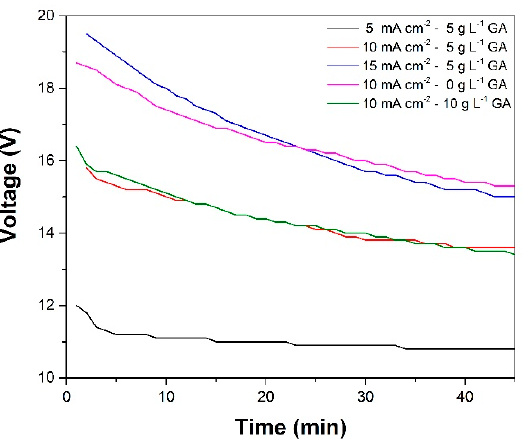
Figure 2. Evolution of cell voltage with time during the anodization of the AA1100 samples at varying levels of gallic acid concentration and anodization current density.